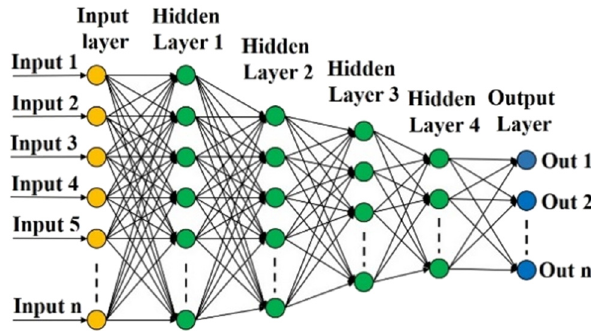
Figure 2: General architecture of